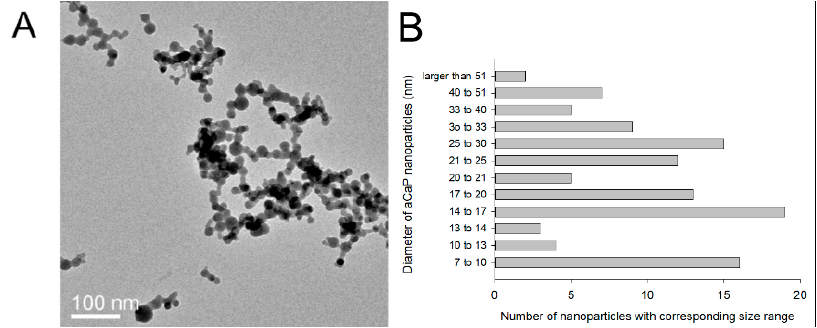
Figure 1. TEM image of the aCaP nanoparticles used in this study ( A ) and size distribution ( B